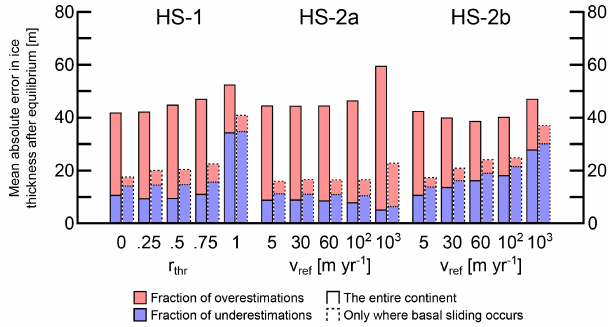
Figure 8. Mean absolute differences between the modelled and ob- served ice thickness at the end of the equilibrium simulations, in × 10 7 km 3 , for different values of free parameters included in the computation of the SStA weight. As in Fig. 2, a mean error is calcu- lated for the entire ice sheet (left bars) and separately over the areas where basal sliding is identified (right bars). Each bar is divided into relative errors arising from under- (blue) and overestimations